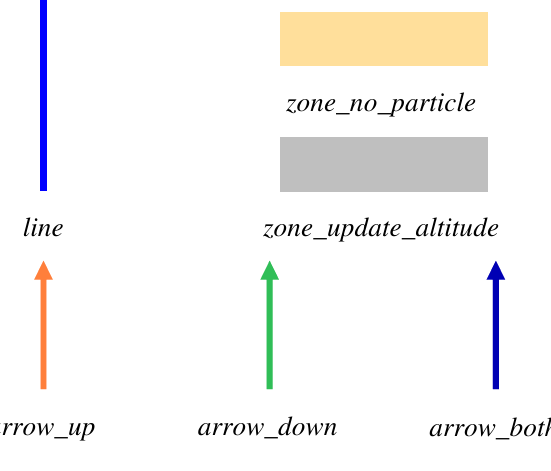
Figure 7. Map components.